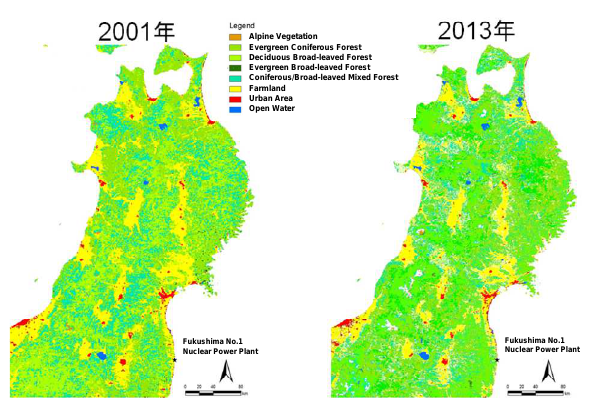
Figure 7. Land cover change in eastern Japan based on Terra/MODIS data for 2001 and 2013